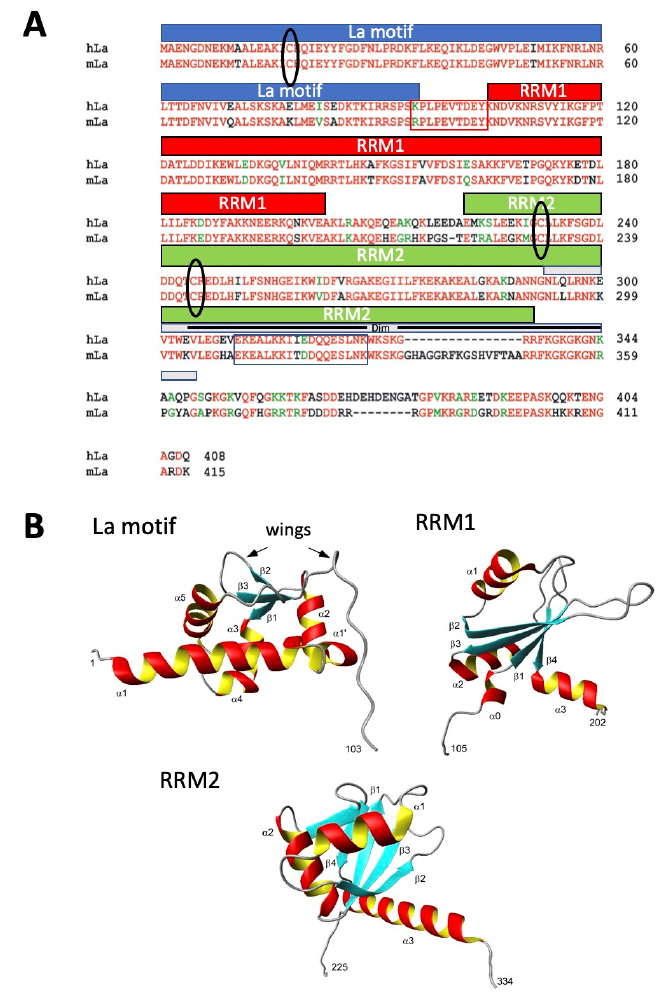
Figure 1. The La protein sequence and structure. ( A ) La protein is conserved during evolution [41,42]. For a detailed review of the sequence and structural comparisons, see also [17]. La proteins contain an N-terminal La motif (blue bar) followed by an RNA recognition motif (RRM1, red bar). The La motif contains an evolutionarily conserved cysteine residue (Cys18). La motif and RRM1 together form the La module (LaM) [17]. In previous studies, the LaM was termed LaN [41–44]. The sequence between the La motif and the RRM1 is unstructured but forms a helical structure in the case La protein binds to RNA [17]. The monoclonal anti-La antibody (anti-La mAb) 5B9 recognizes this linker (aa311-328 (KPLPEVTDEY, red box)) between the La motif and the RRM1 domain. Recently, mAbs were described by us being directed to conformational epitopes in the La motif (312B, 2F9, 32A, 27E) and RRM1 (22A, 24G7) [45]). Downstream of RRM1 La protein contains a second RRM (RRM2). The RRM2, together with the downstream sequence, represents the previously termed C-terminal La fragment LaC [41–44]. The RRM2 contains a dimerization domain (Dim, gray bar) [14]. Within this region, a nuclear retention element (NRE) [15] and a nucleolar localization signal (NoLS) [16] were identified. The epitope sequence (EKEALKKIIEDQQESLNK (aa311-328)) recognized by the anti-La mAb 7B6 is also part of this region (blue box, see also below). The data presented below show that aa304-344 is sufficient for dimerization (black line in the gray bar). The RRM2 domain contains the two cysteine residues (Cys232 and Cys245), playing a central role in the ALARM NMR assay [21–23]. ( B ) The structure of La protein is partially solved [17–19]. Structural data are available for the La motif, the RRM1 and RRM2 domain. The La motif contains two “wings”. The interdomain sequence, which contains the epitope recognized by the anti-La mAb 5B9, starts downstream of the second wing. The epitope of anti-La mAb 7B6 includes most of the α 3-helix in the RRM2